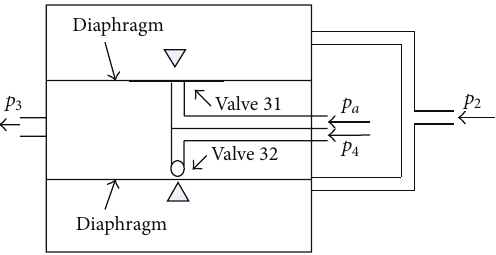
Figure 3: Functional structure of pneumatic